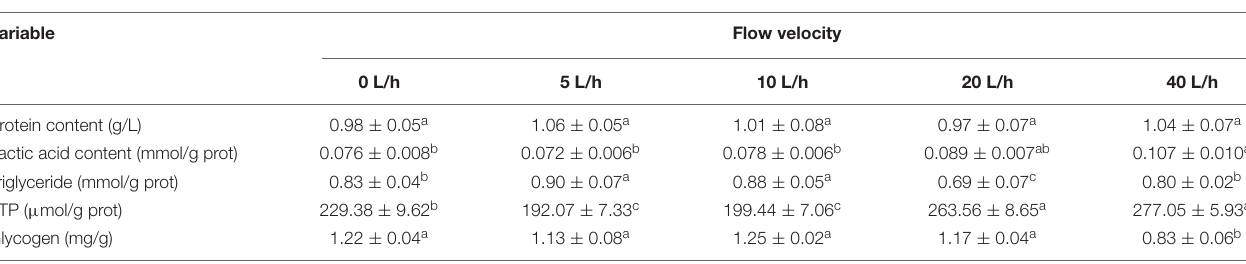
TABLE 4 | Biochemical content of H. discus hannai larvae, reared under different flow velocities.